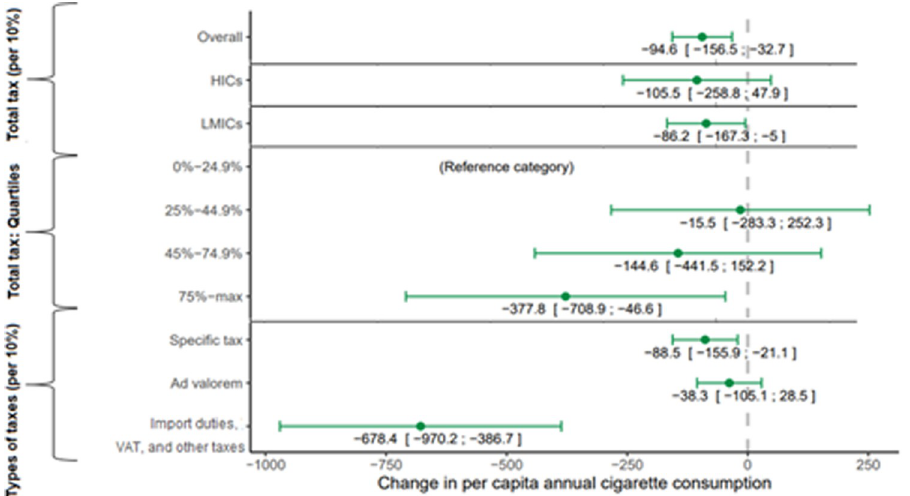
Fig 3. Association between tobacco taxes and cigarette consumption per capita by different income groups, tobacco tax quartiles, and the type of taxes (B-value and 95% CI). Note: This figure contains only the exposure variables; the entire analysis is available in S6 Table (appendix p 7). The B-values are all derived from a fixed-effect model. Tax is expressed as a percentage of the retail price. Abbreviations: CI = Confidence interval; VAT = value- added tax; HICs = High-income countries; LMICs = Low- and middle-income countries.